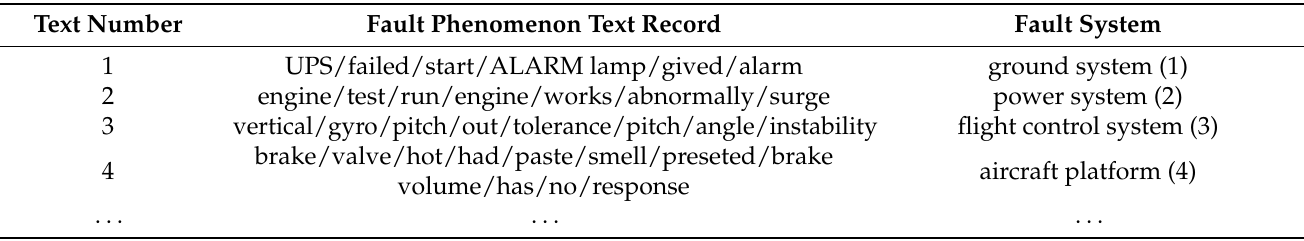
Table 3. Examples of fault phenomenon recording text data after preprocessing.